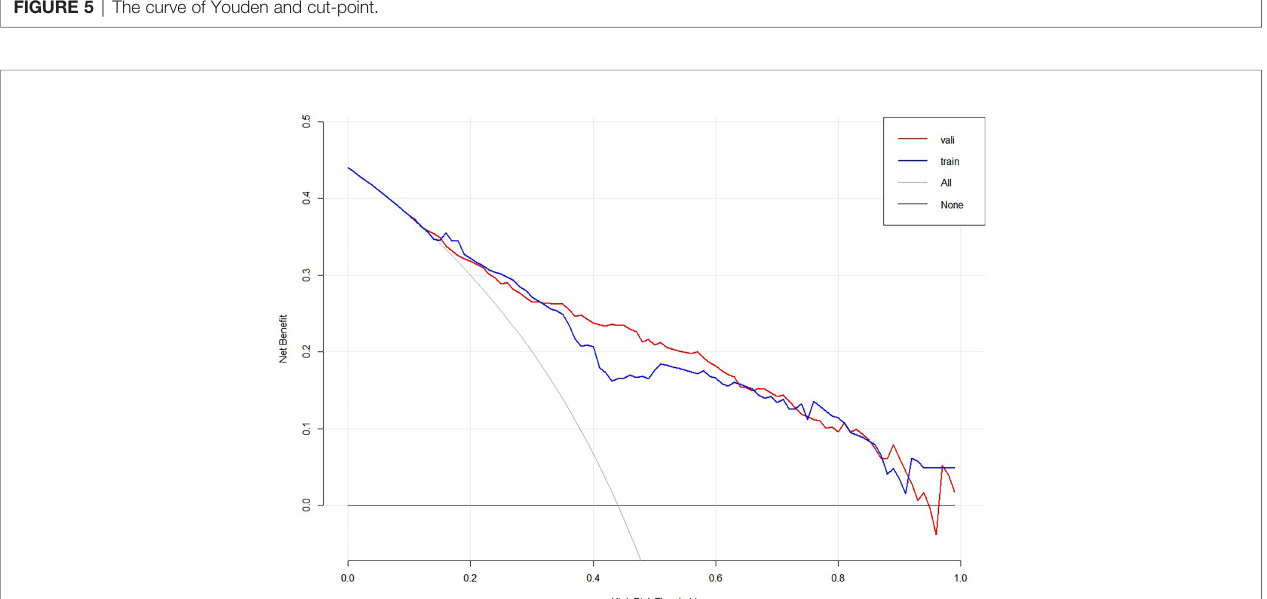
FIGURE 5 | The curve of Youden and cut-point.